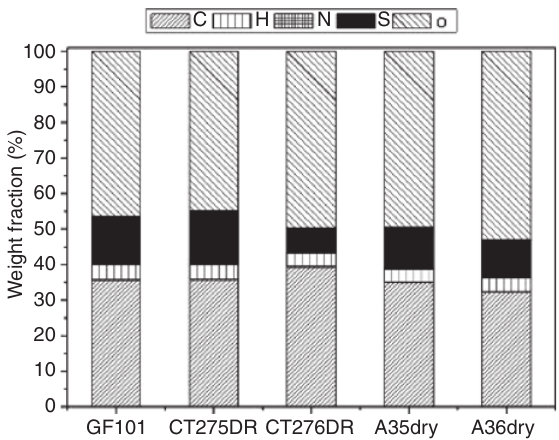
Figure 6: Elemental microanalysis of the ion exchange resins.